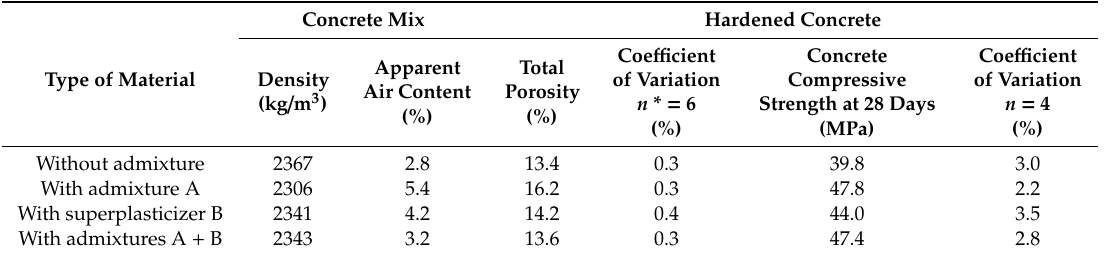
Table 2. The obtained test results for the concrete mixes and the hardened